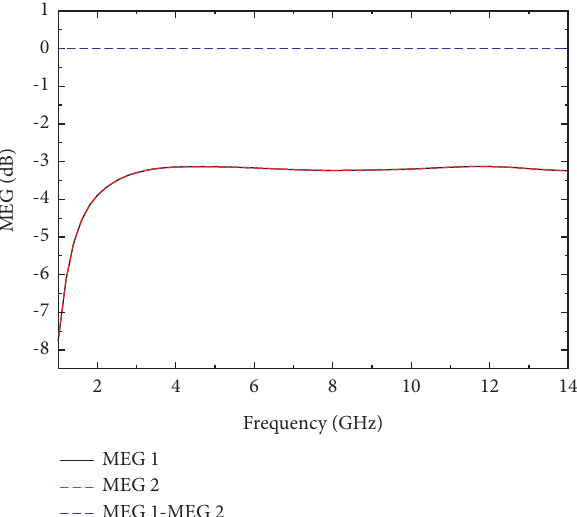
Figure 20: Graph of measured MEG results.